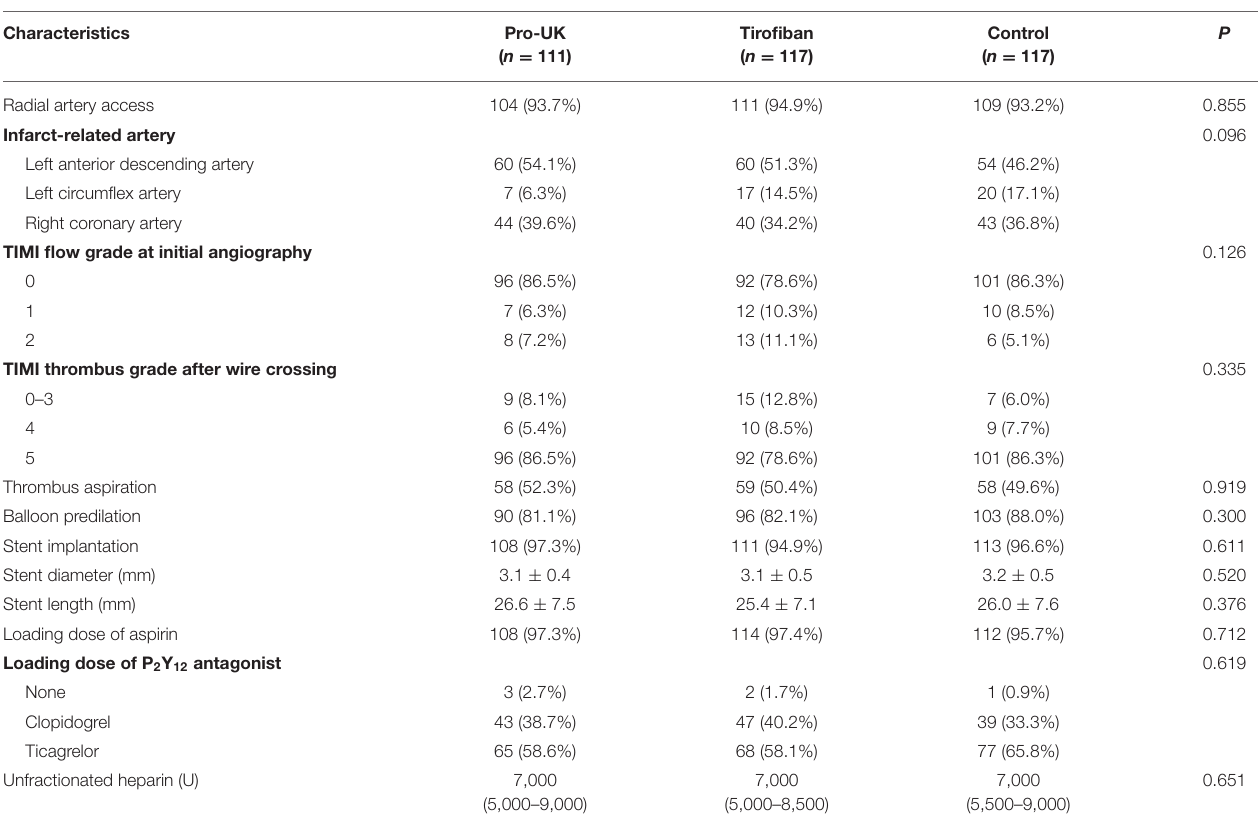
TABLE 2 | Procedural